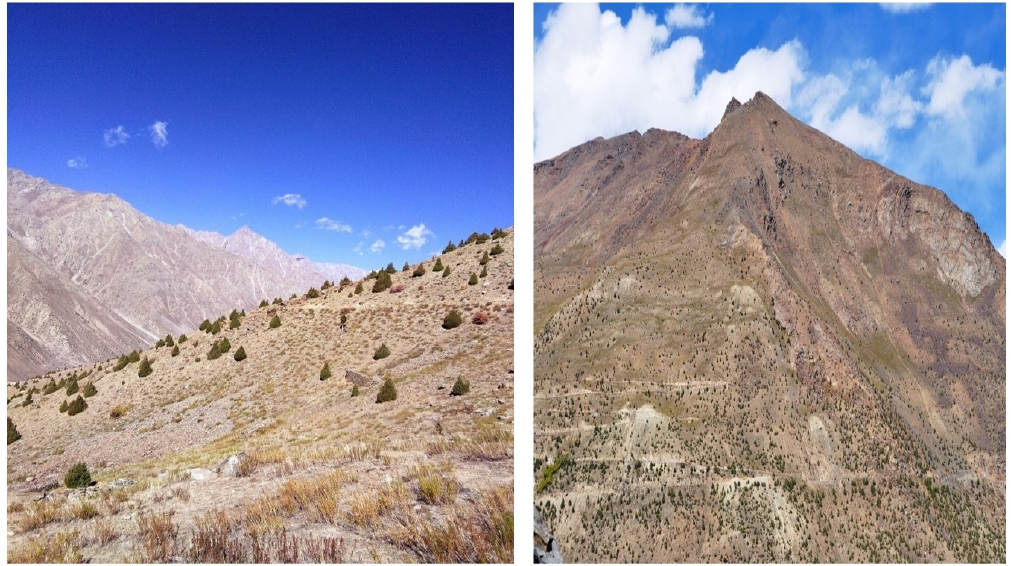
Figure 7. Juniperus macropoda migration in Lahaul Valley.